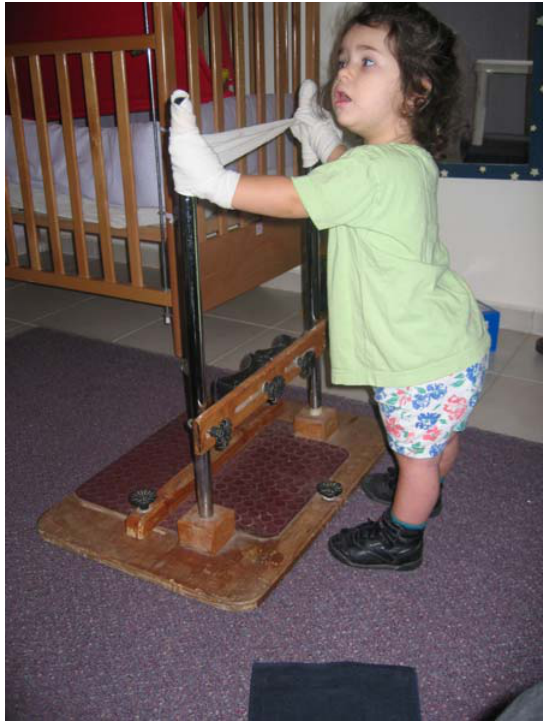
FIGURE 3. An active standing